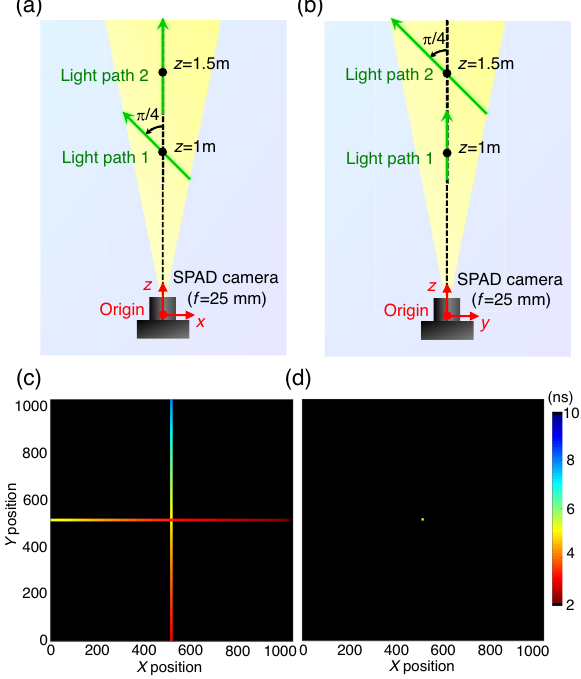
FIG. 6. Virtual setup and data set generated by Monte Carlo simulation of four-dimensional light-in-flight imaging for two separate light trajectories. (a) Schematic illustration for top view of the virtual setup. (b) Schematic illustration for side view of the virtual setup. (c) Time stamps for primary events detected at each pixel, generated by Monte Carlo simulation. The black region indicates “ no data. ” (d) Generated time stamps for secondary events.